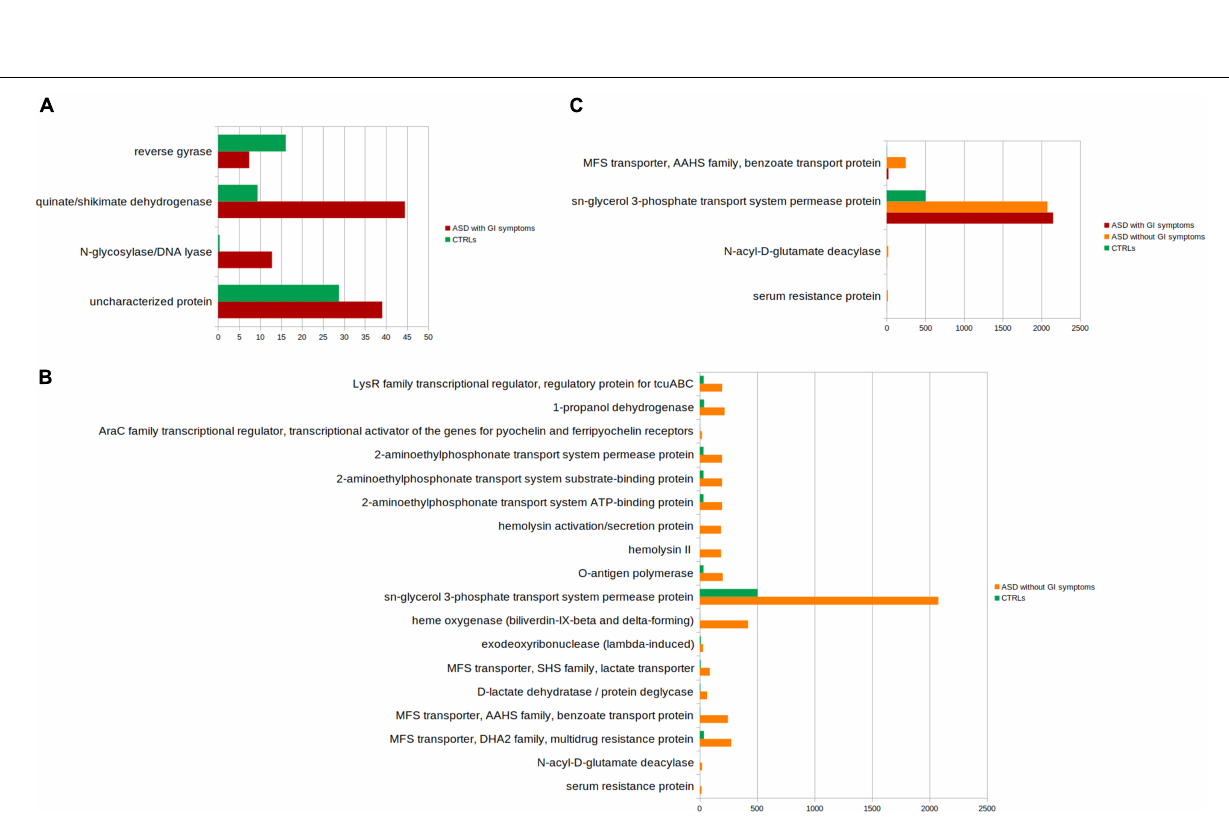
FIGURE 8 | Kyoto Encyclopedia of Genes and Genomes (KEGG) biomarkers inferred from the whole set of OTUs of the patients with ASD grouped into the patients with GI and without GI symptoms versus the CTRLs subjects. KOs distribution for each group computed by the Kruskal-Wallis test ( p -value < 0.001 and relative abundances > 10). (A) ASD with GI symptoms versus CTRLs; (B) ASD without GI symptoms CTRLs; (C) ASD with GI versus ASD without GI symptoms and versus CTRLs. In red, ASD with GI symptoms; orange, ASD without GI symptoms; green,